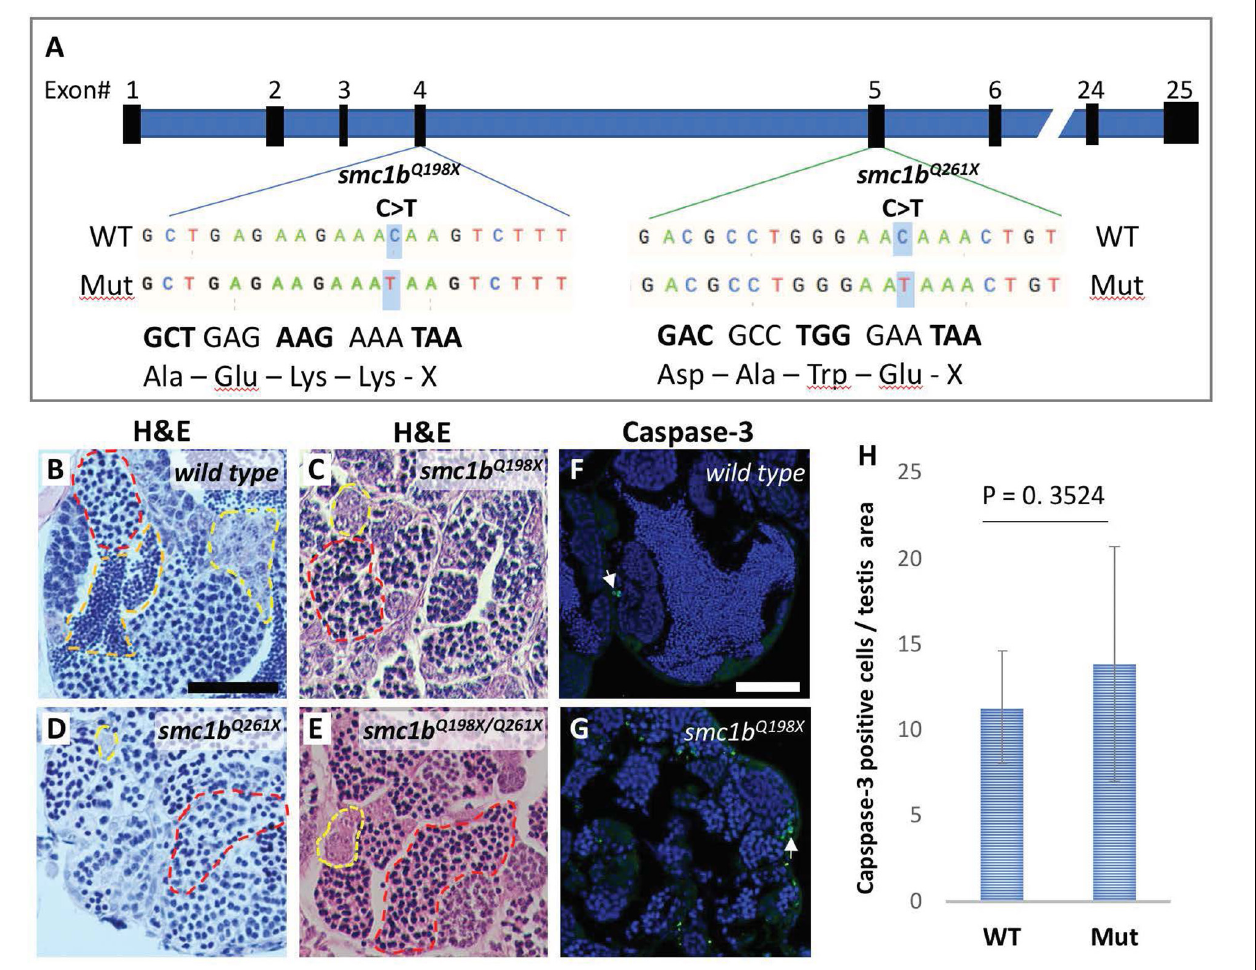
FIGURE 2 | Smc1b mutant zebrafish display defects in spermatogenesis. (A) Smc1b mutations used in this study: s mc1b Q198X located in exon 4 and smc1b Q261X in exon 5. Both mutations cause premature termination codons. (B–E) Hematoxylin-eosin (H&E) staining on adult testes of wild type (B) , smc1b Q261X ( − / − ) (C) , smc1b Q198X ( − / − ) (D) , and smc1b Q198X / Q261X (E) . Dashed lines denote examples of: spermatogonia (yellow), spermatocytes (red), and spermatozoa (orange). (F,G) Caspase-3 (green) and DAPI (blue) staining on adult testes from wild type (F) and smc1b mutant (G) . Caspase-3 positive cells are indicated by arrows. (H) Quantification of caspase-3 positive cells per testis area in the mutant ( N = 3 testes) and wild type ( N = 3 testes). Student’s t -test shows no significant ( p = 0.3524) difference between wild-type and mutant caspase-3 positive cells numbers. Scale bars are 50 µ m.